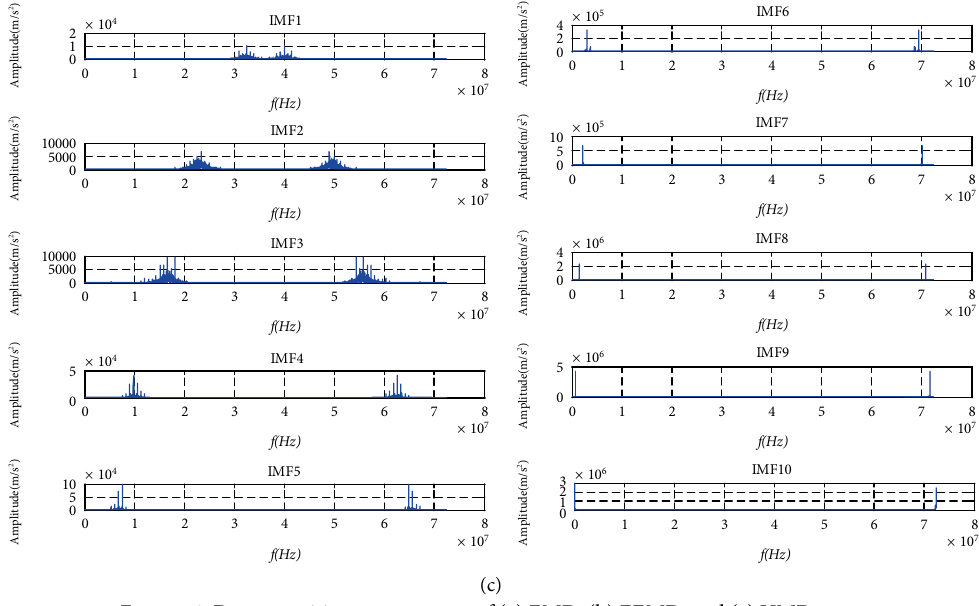
Figure 4: Decomposition spectrogram of (a) EMD, (b) EEMD, and (c) Table 2: The influencing factor feature set built and the representa- tion method.